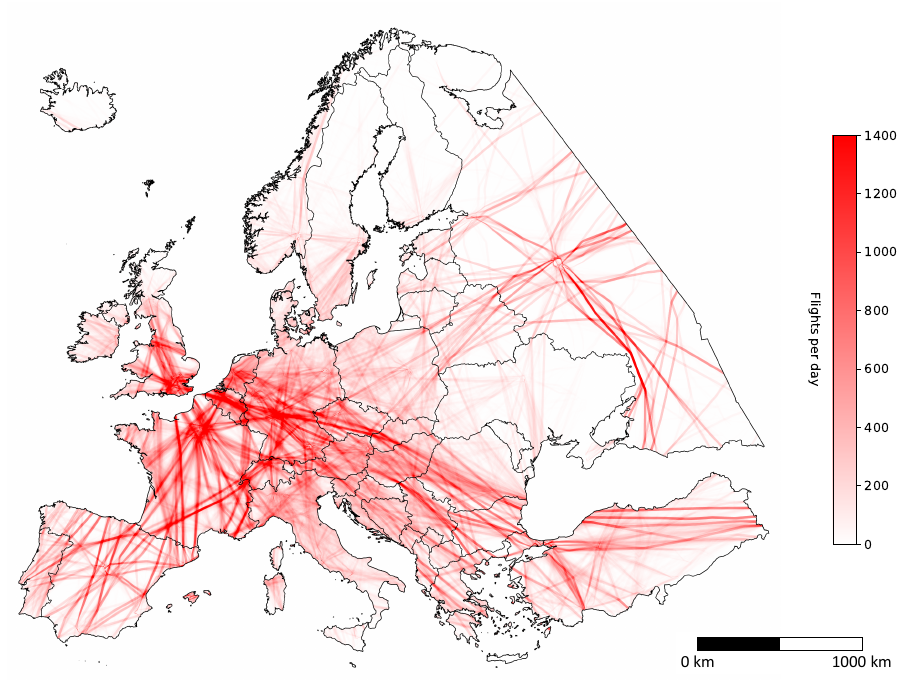
Figure 13. Number of flyovers by all fights with Imperx T9040.